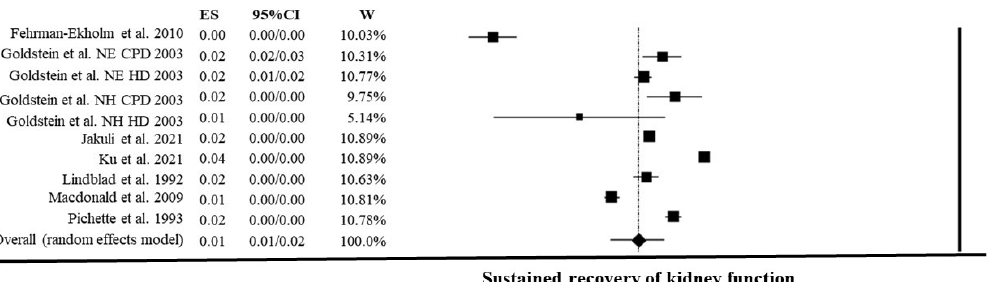
Figure 2. Random effect meta-analysis of recovery of kidney function percentage on 2,444,943 chronic dialysis patients [2,6,15–19].